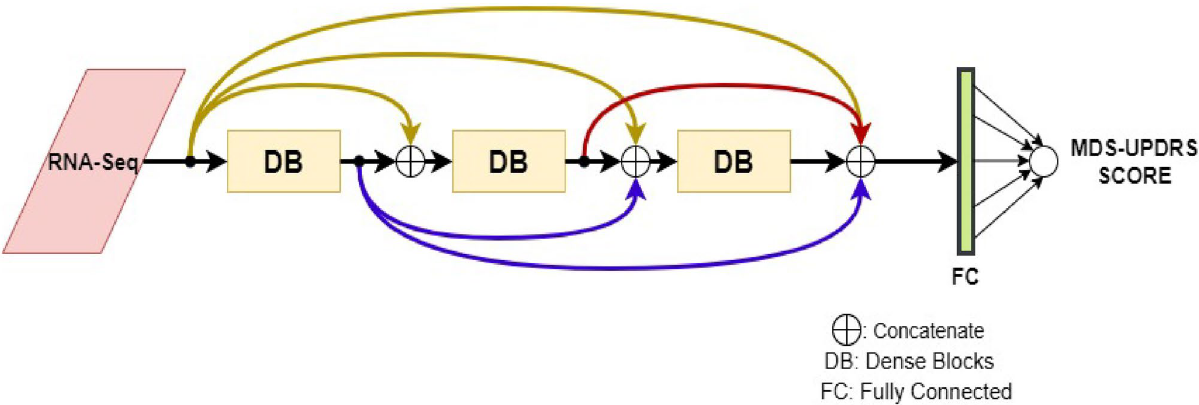
Figure 4. Proposed Densely Connected RNN Architecture. Multiple Dense blocks are stacked on top of each other and are connected in dense fashion. The output of the last dense block flattened and connected to a single neuron. Note that the number of dense blocks is an important hyperparameter and may be